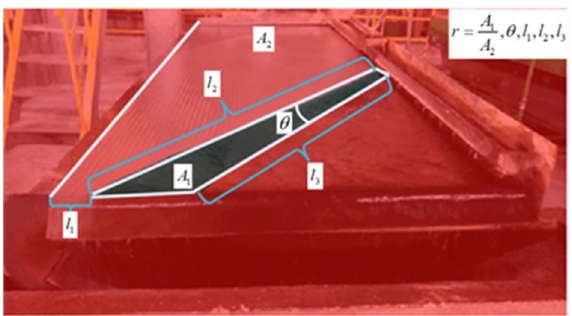
Figure 2. The principle of image feature extraction of multi-scale ore